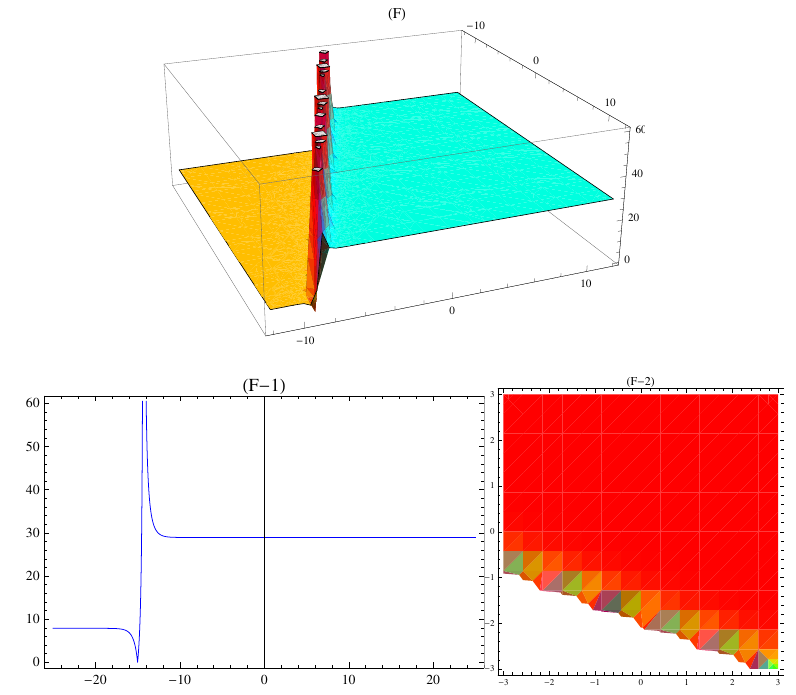
Figure 6: (F) 3D graph of (63) with θ = 2.5 , λ = 3.1 , µ = 1.5 , Θ = 1.4 , p = 0.98 , q = 0.95 , k = 2.1 , A = 2.8 , δ = −2 , ς = 2 , c = 2.3 , y = 1.7 , l = 1.9 . (F-1) 2D plot of (63) with t = 1 . (F-2) Contour graph of (63).